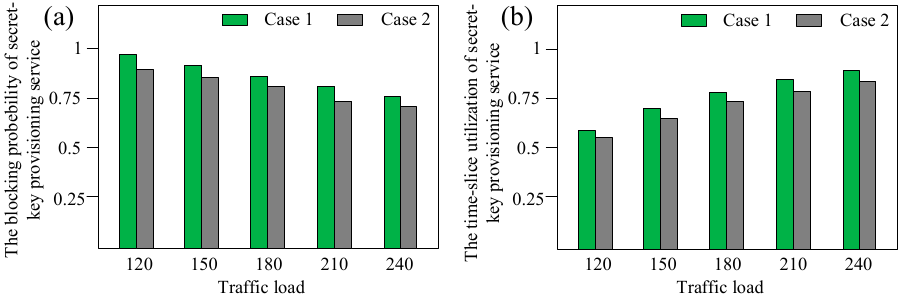
Figure 8. ( a ) The ratio of successful QKP construction, ( b ) the resource utilization.